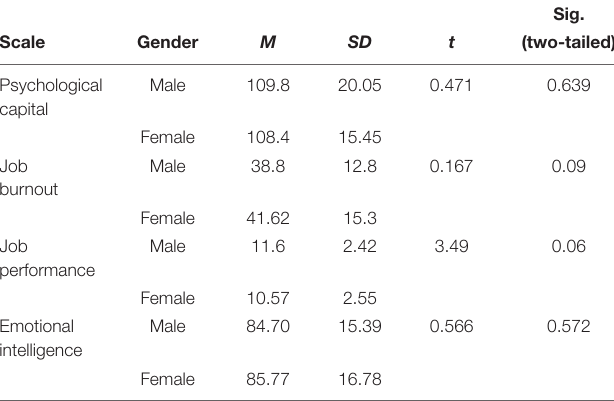
TABLE 5 | t test on gender of each scale.